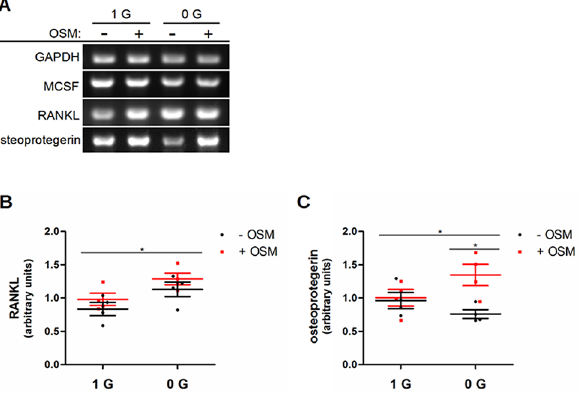
Fig 4. OSM counteracts the effect of RCCS on the RANKL: osteoprotegerin ratio. Semi-quantitative RT-PCR was used to examine the interaction of OSM and modeled microgravity on the osteoblast transcription of MCSF, RANKL, and osteoprotegerin. (A) Representative images from samples collected after 48 h, when the most significant effects were seen for RANKL and osteoprotegerin. No changes were detected for MCSF or with radiation for any of these targets. Significant effects when quantified by densitometry are shown as scatter plots with mean and SEM for RANKL (B) and osteoprotegerin (C). RANKL transcription increased under RCCS (B), without an associated increase in osteoprotegerin (C). The combination of OSM and RCCS, however, increased osteoprotegerin proportionally to the increase in